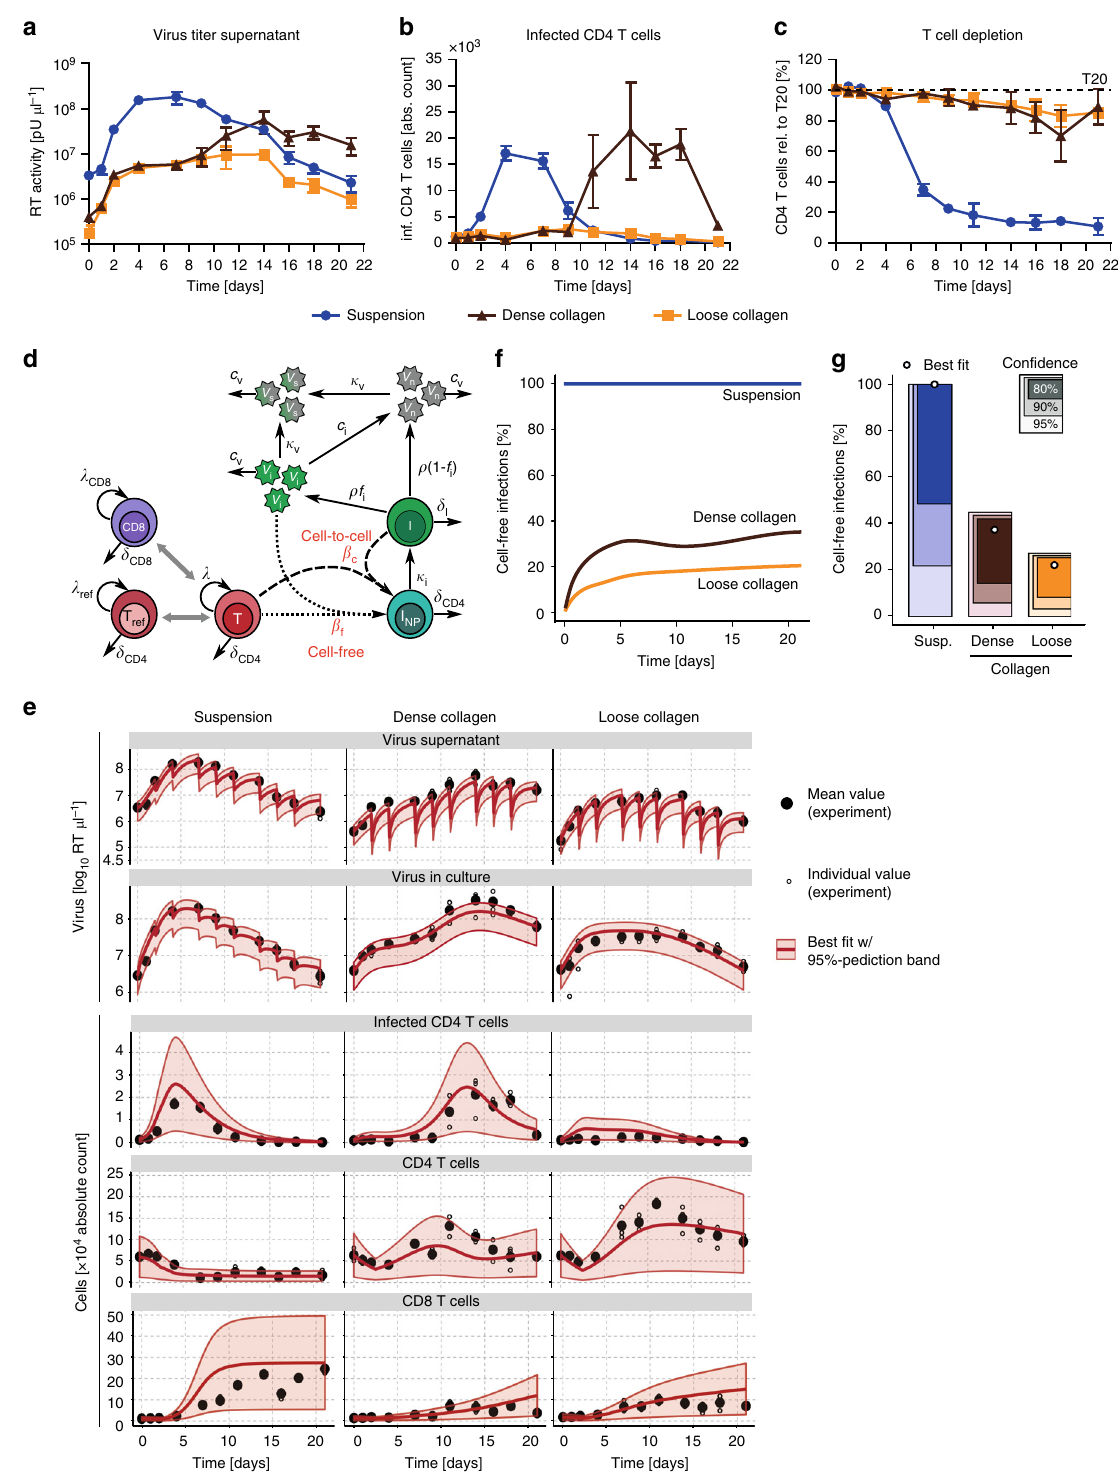
Single-cell motility and contact analysis . The kinetic mathe- matical model indicated a comparable or even slightly higher contribution of cell – cell transmission in loose than in dense collagen cultures and cell-free infectivity was equally impaired by dense and loose collagen. The slower virus spread observed in loose collagen therefore suggested that cell – cell transmission is particularly inef fi cient under this culture condition. Due to the spacing between donor and target cells in 3D, cell motility is a prerequisite for cell-associated virus spread in these